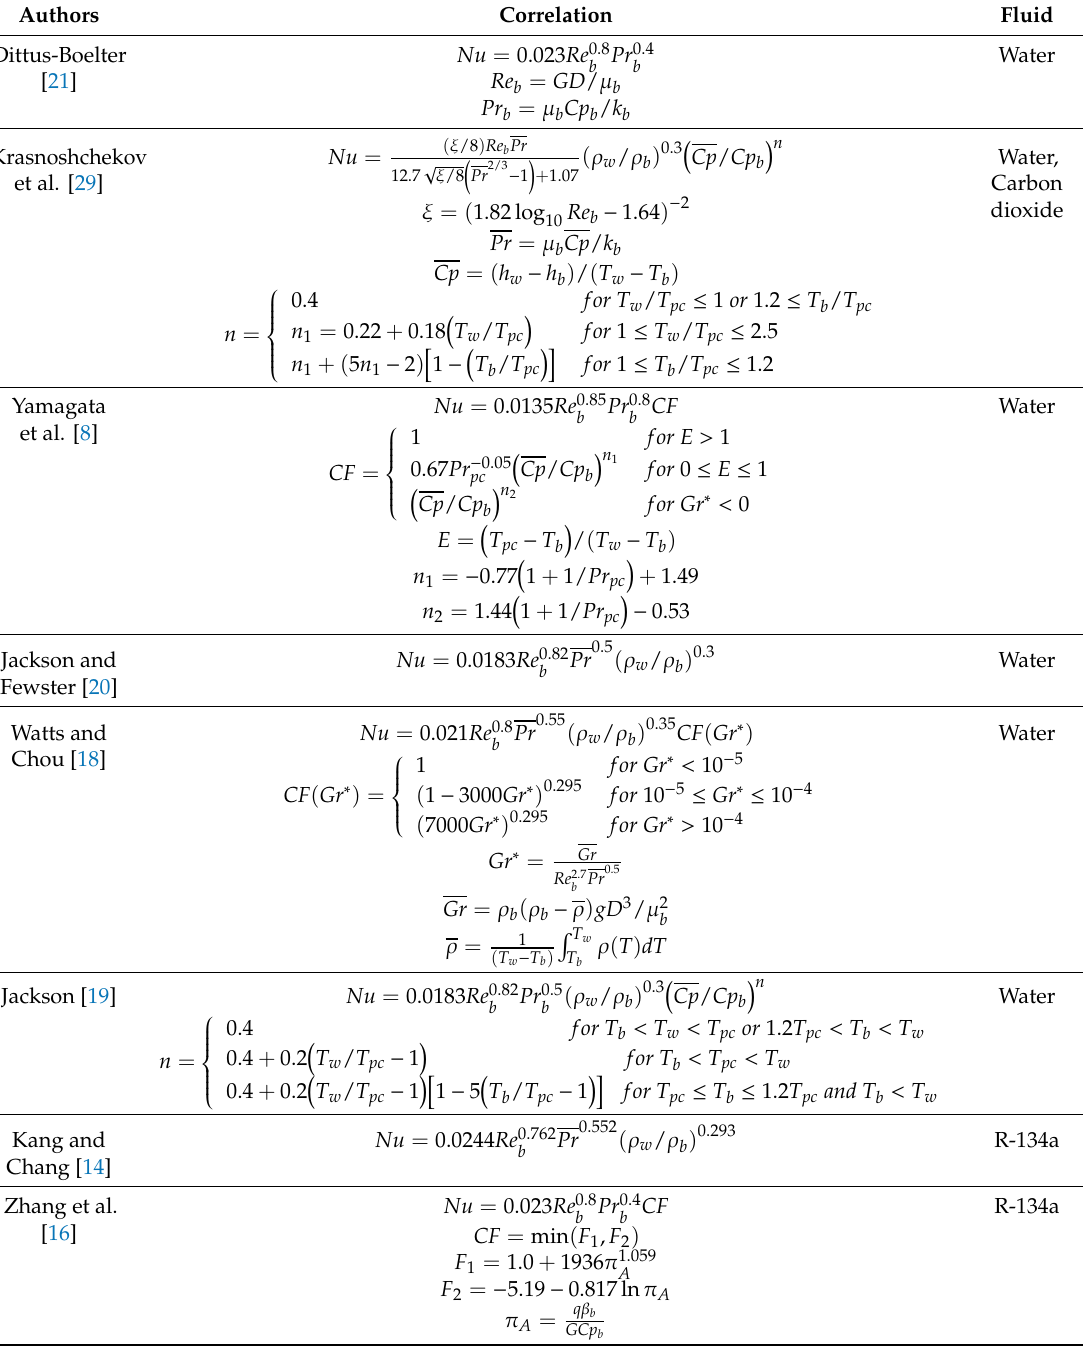
Table 6. Some correlations used for comparisons against the experimental data subject to supercritical